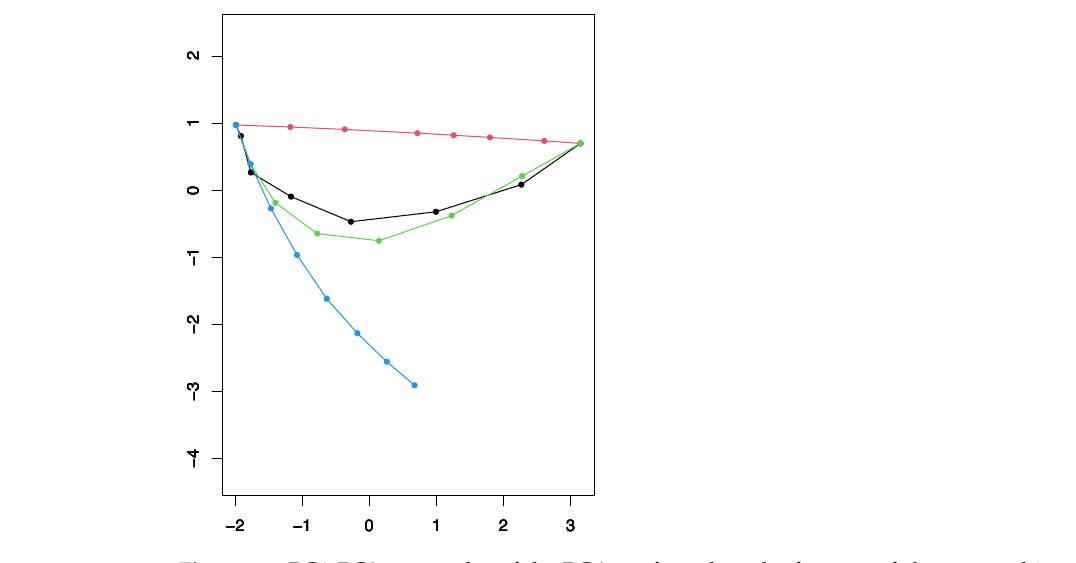
Figure 15. PC1-PC2 scatterplot of the PCA perfomed on the four set of shapes resulting from the bending+general affine component case. PC1 explains 62.61% of total variance, while PC2 explains 25.48%. Black refers to the optimized shapes, red to the linearized, green to the original shapes and cyan to the shooted